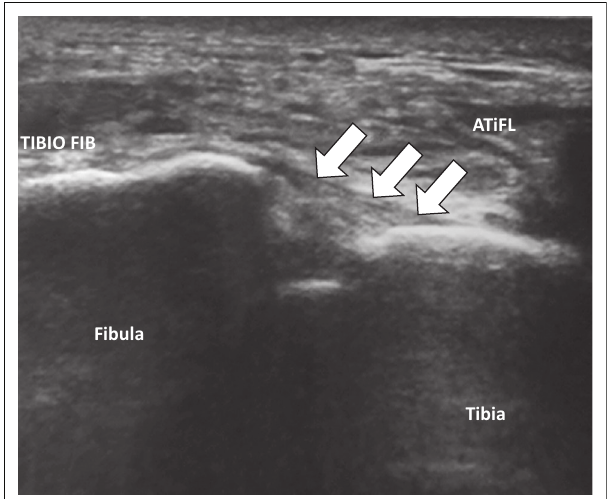
FIGURE 7: Foot placed in dorsiflexion for the tibiofibular clear space measurements with the transducer placed in a longitudinal oblique section at the level of the anterior tibiofibular ligament.